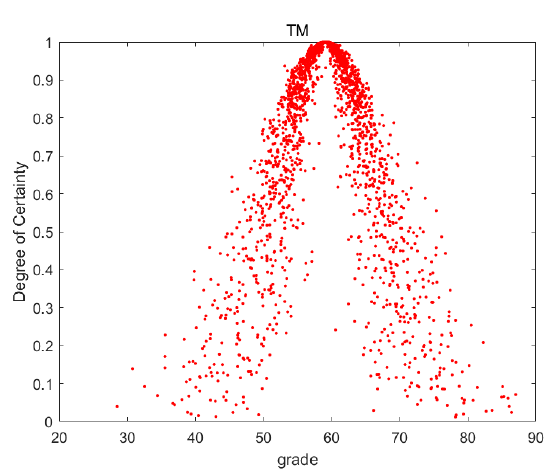
Figure 5. Cloud image of TM.